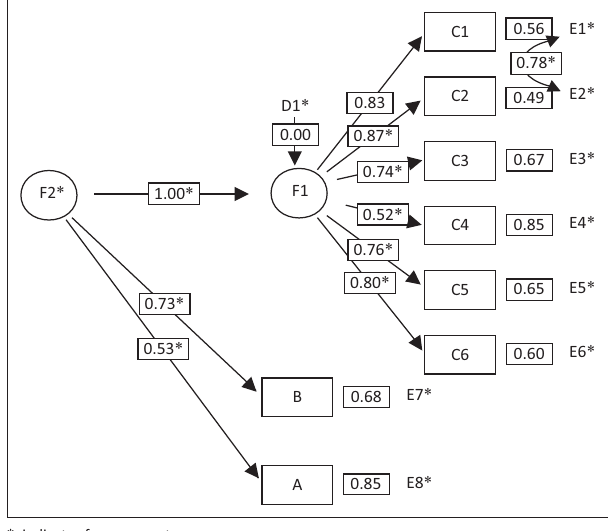
FIGURE 6: Higher-order latent variable structural model of the Experience of Work and Life Circumstances Questionnaire based on the sample data ( N =